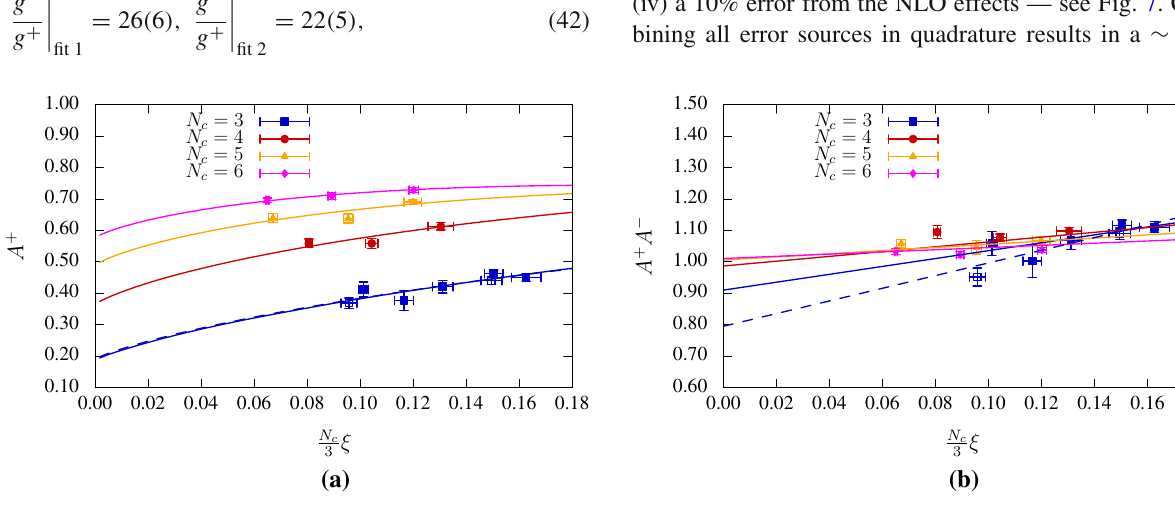
fit as in Eq. (23). Dashed lines represent the chiral extrapolation of the data points for N c = 3 following Eqs. (23) and (27). Errors are